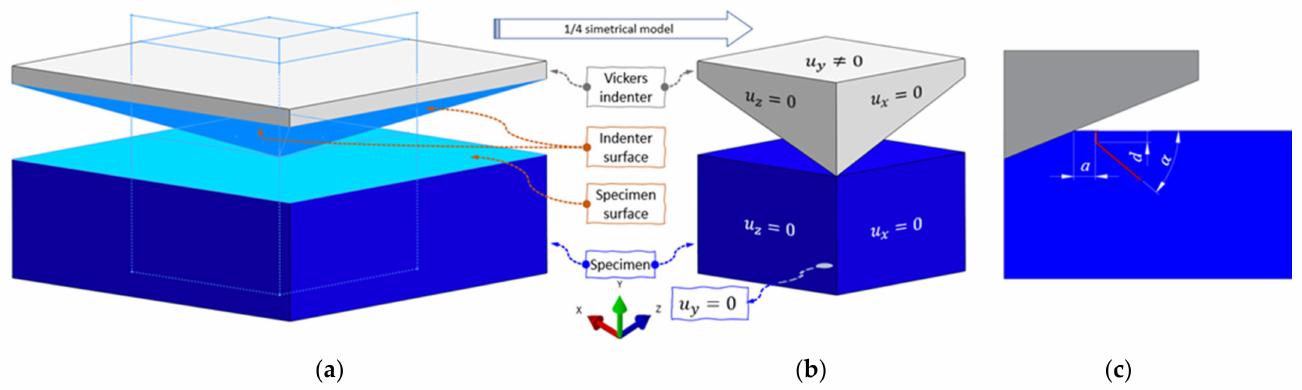
Figure 4. Numerical model of Vickers indentation: ( a ) full model, ( b ) quarter symmetrical model with symmetry boundary conditions, and ( c ) idealized